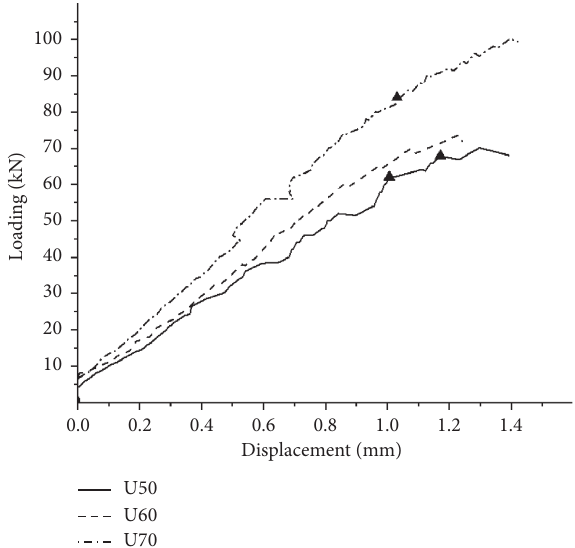
Figure 14: Load-displacement curves of tested beams without